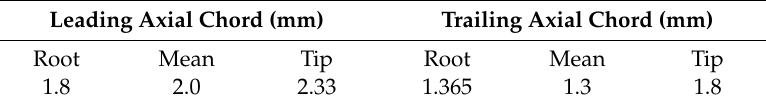
Table 14. Final parameters of the rotor, leading and trailing axial chords.